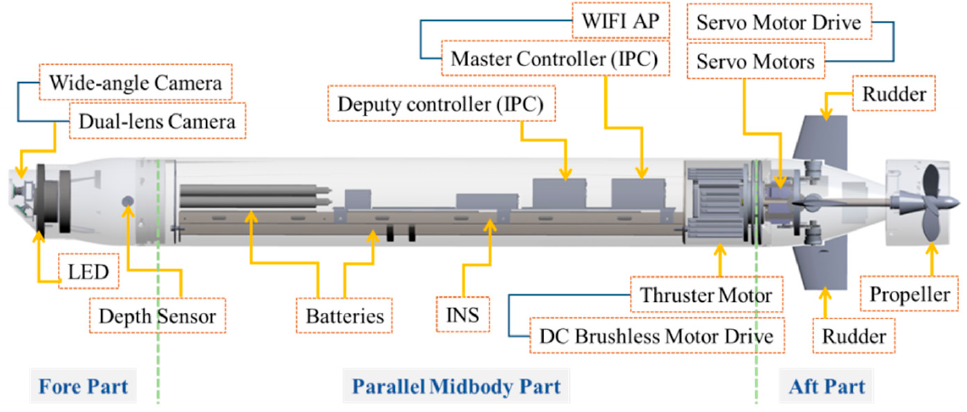
Figure 1. Schematic of Bigeye Barracuda. Table 1. Bigeye Barracuda specifications.